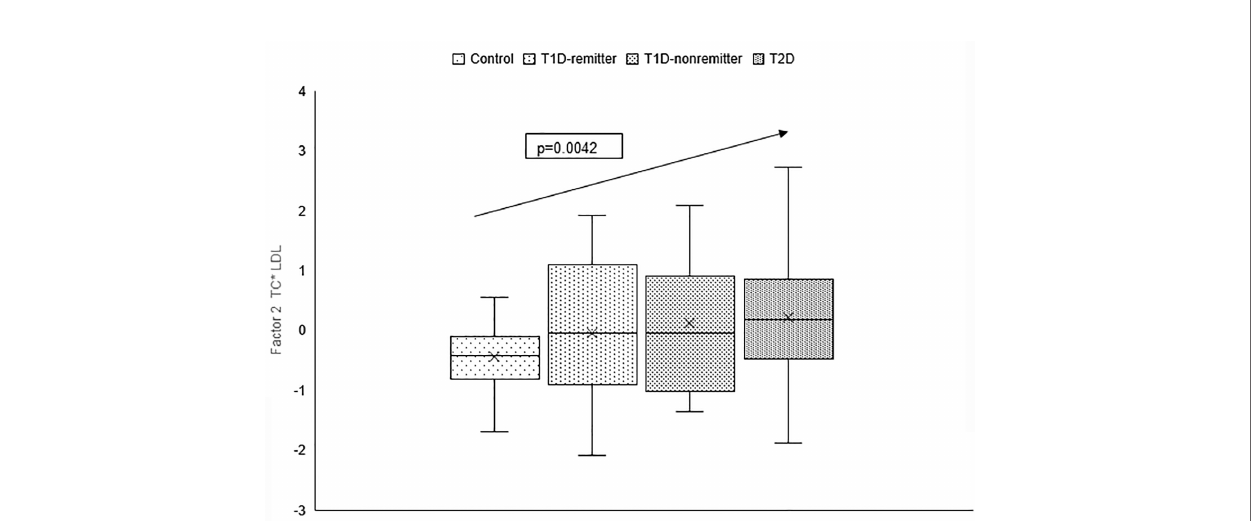
FIGURE 6 | Box plots of the factorial analysis of the American Diabetes Association-recommended initial lipid parameters for the assessment of CVD risk in adults with diabetes namely, TG and HDL, and the atherogenic index of plasma, TG/HDL as designated as summary factor 2 (HDL*TG) obtained with the factor loading threshold of ≥ 0.45 in 203 adults. Factor 2 explained 90% of the variance in the original lipid parameters with a linear increase in mean composite scores from controls, remitters, non-remitters, and subjects with type 2 diabetes